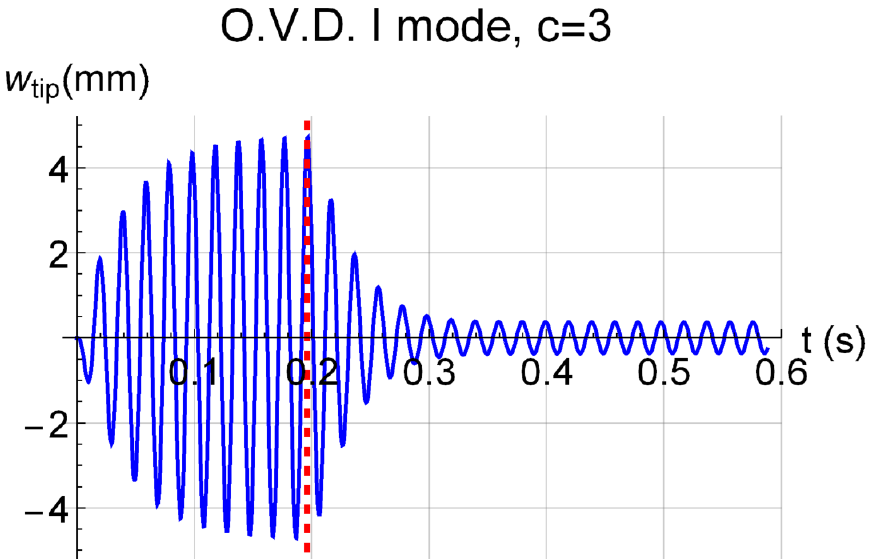
Figure 14. Example of damping efficacy of the O.V.D. when the first eigenmode was excited by a harmonic moment (amplitude = 1.8 Nm) concentrated at the tip. The dashed red line shows the instant of O.V.D.